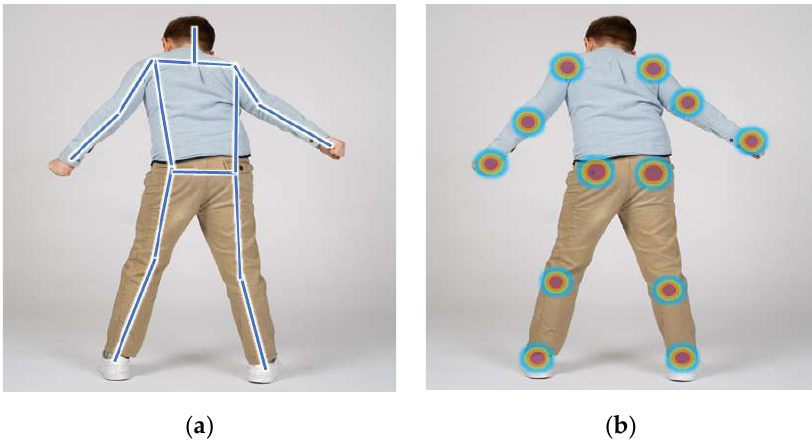
Figure 4. Posture estimation technique: ( a ) Heatmap; ( b ) Regression.